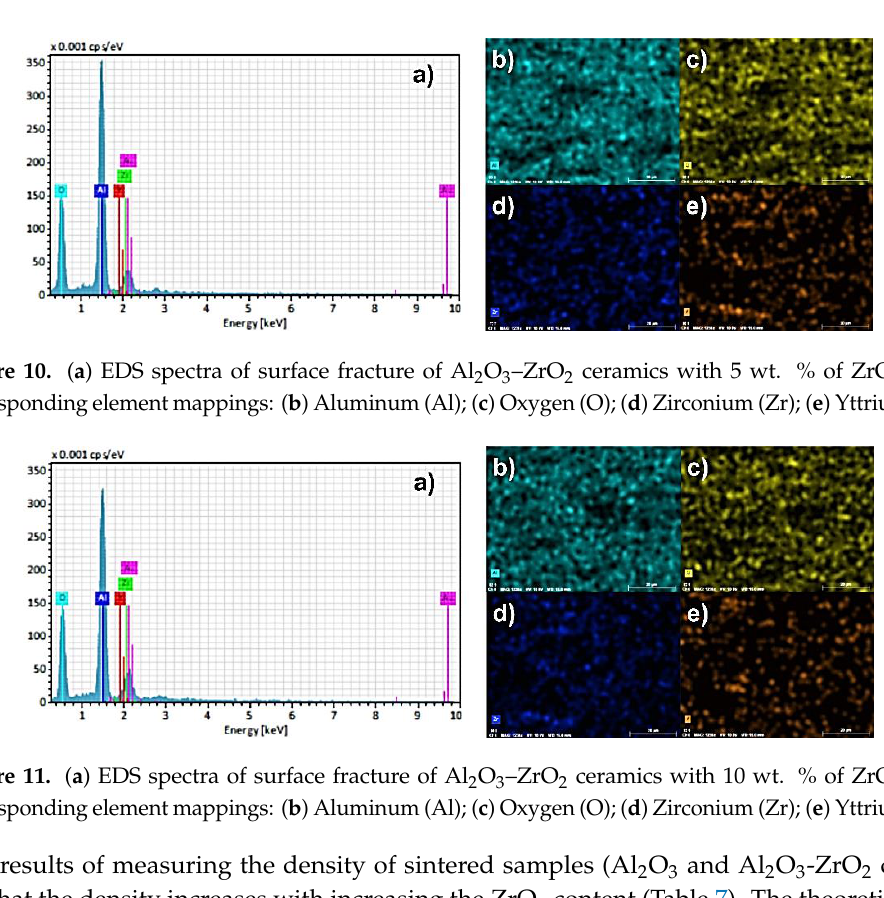
Figure 9. ( a ) EDS spectra of surface fracture of Al 2 O 3 –ZrO 2 ceramics with 1 wt. % of ZrO 2 and corresponding element mappings: ( b ) Aluminum (Al); ( c ) Oxygen (O); ( d ) Zirconium (Zr); ( e ) Yttrium (Y).